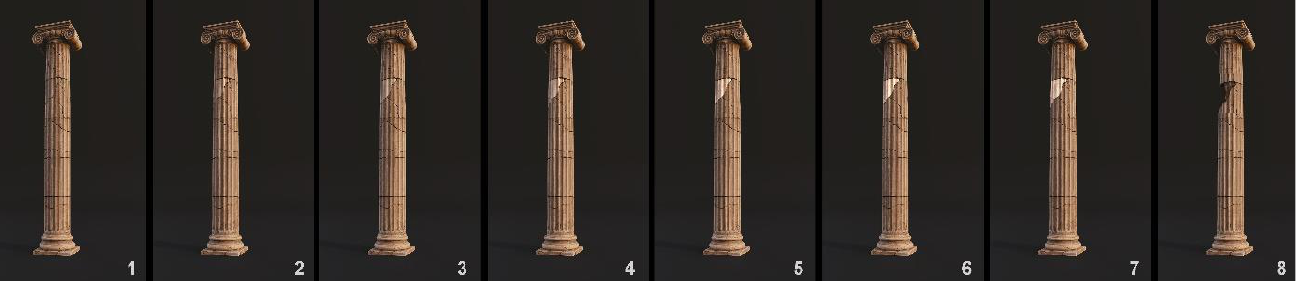
Figure 1. Three types of anastylosis used in the experiment: ( A ) complete; ( B ) with an empty cavity; ( C ) with a cavity filled with lighter stone.